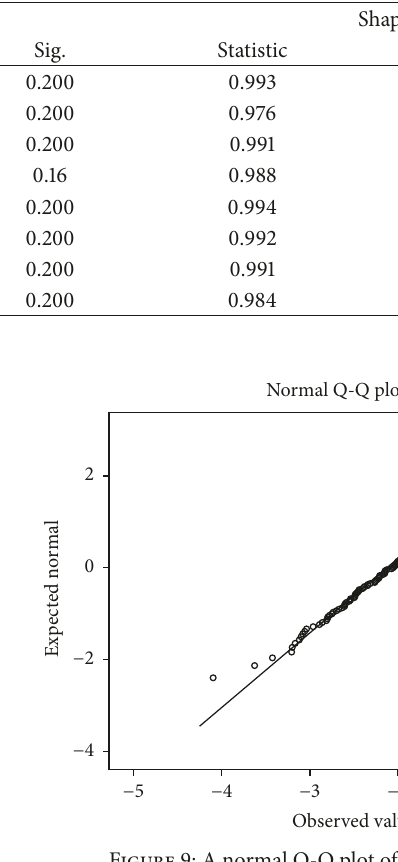
Figure 9: A normal Q-Q plot of Arias